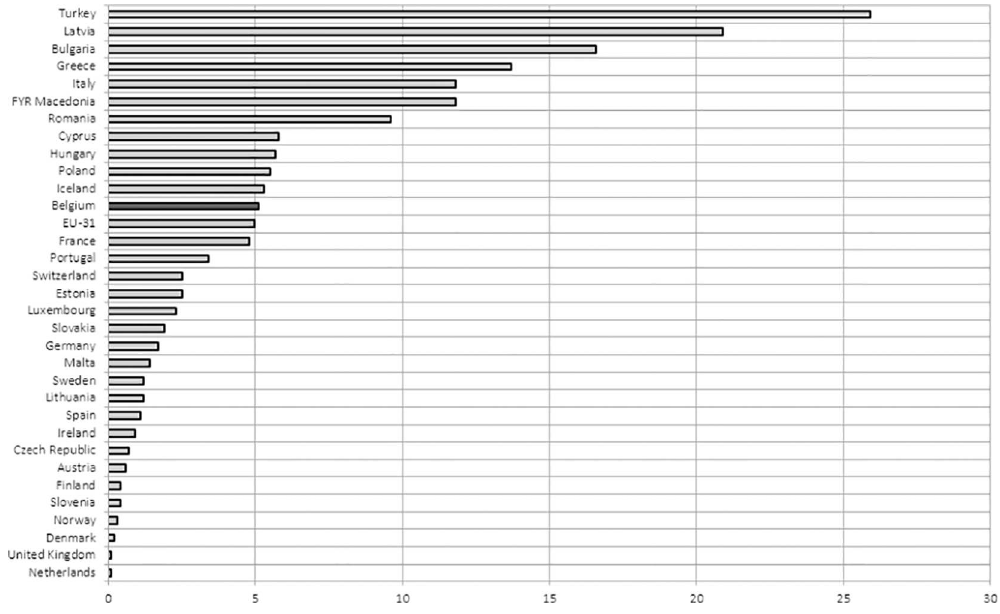
Fig 2. Gap unmet health care needs between low and high income groups. Source Authors’ representation basedon the EU-SILC data